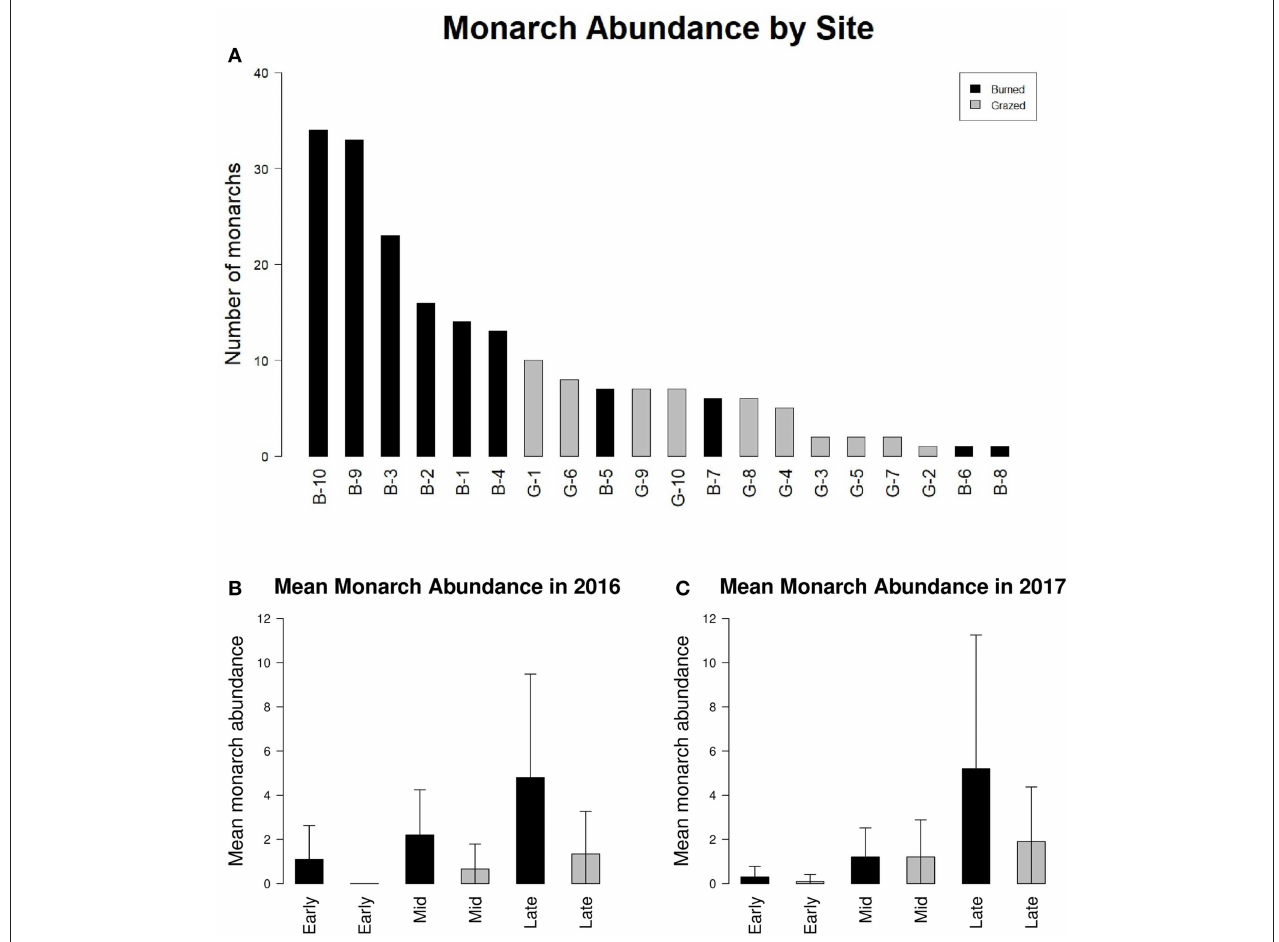
FIGURE 2 | (A) Index of monarch abundance at burned sites (black bars) and grazed sites (gray bars) and (B) mean monarch abundance at burned sites (black bars) and grazed sites (gray bars) for early season (May-June), mid season (June-July), and late season (July-August) survey periods during 2016 and (C) 2017. Error bars in (B,C) represent standard deviation between